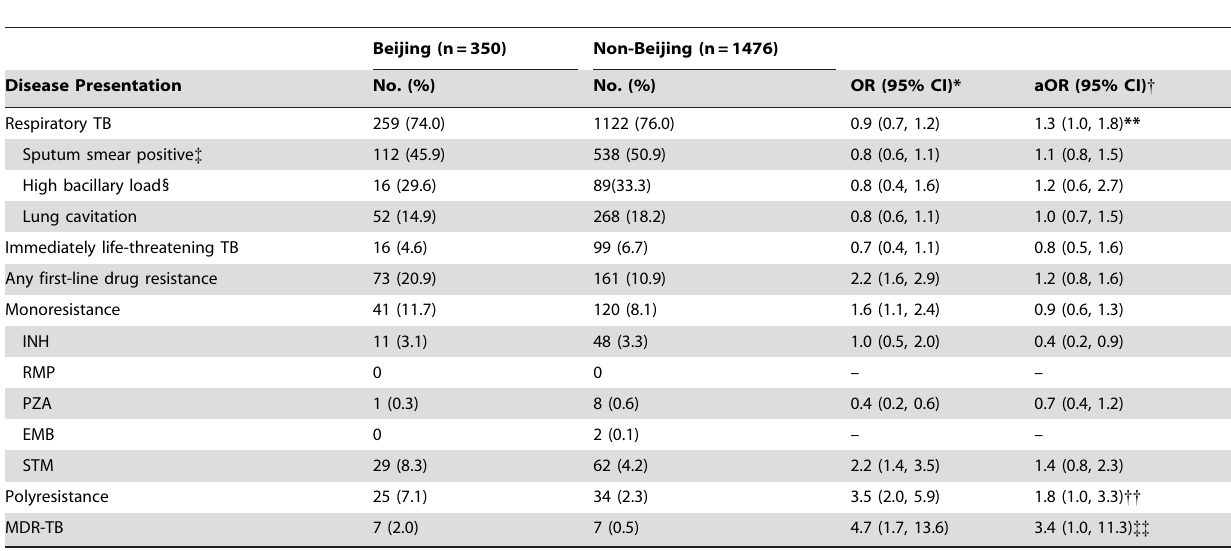
Table 2. Association between M. tuberculosis lineage and disease presentation in Alberta, 1991 to